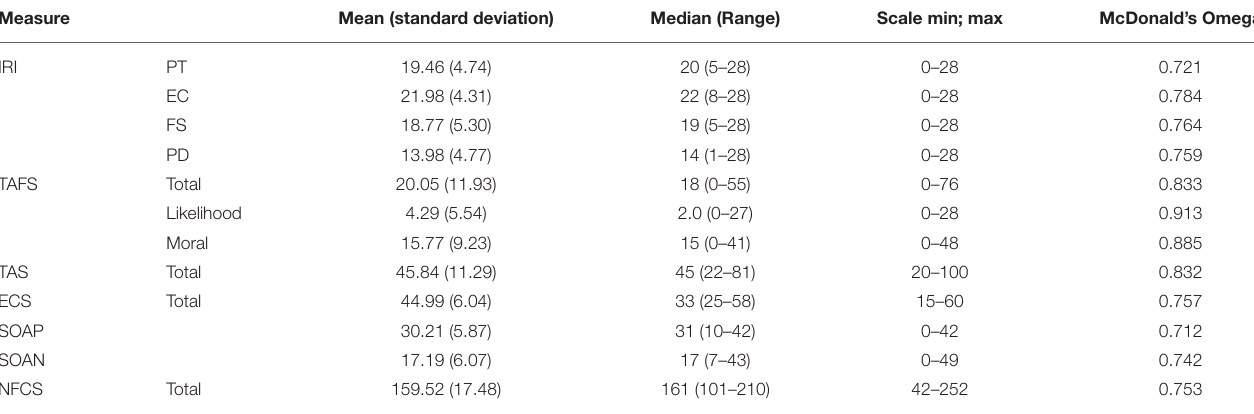
TABLE 1 | Descriptive statistics for each